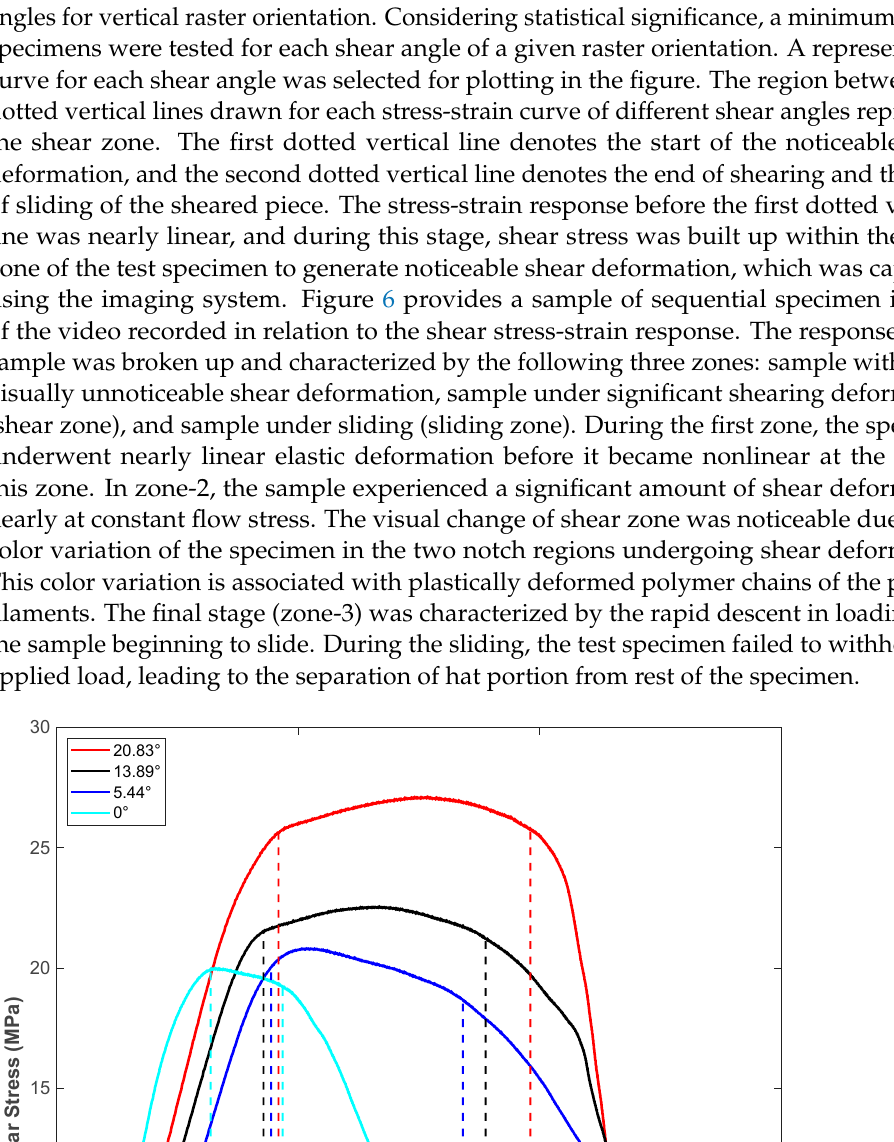
Figure 6. Example of the Shear zone in a vertical raster-oriented print provided with real time pho- tos from video recording taken at each section in the graph. Sections are denoted by the correspond- ing letters of arrows; ( a , b ) represent the specimen undergoing small visually unnoticeable shear deformation, ( c , d ) represents the shear zone in which the specimen begins to deform significantly, and ( e ) represents the sliding of the sheared piece.